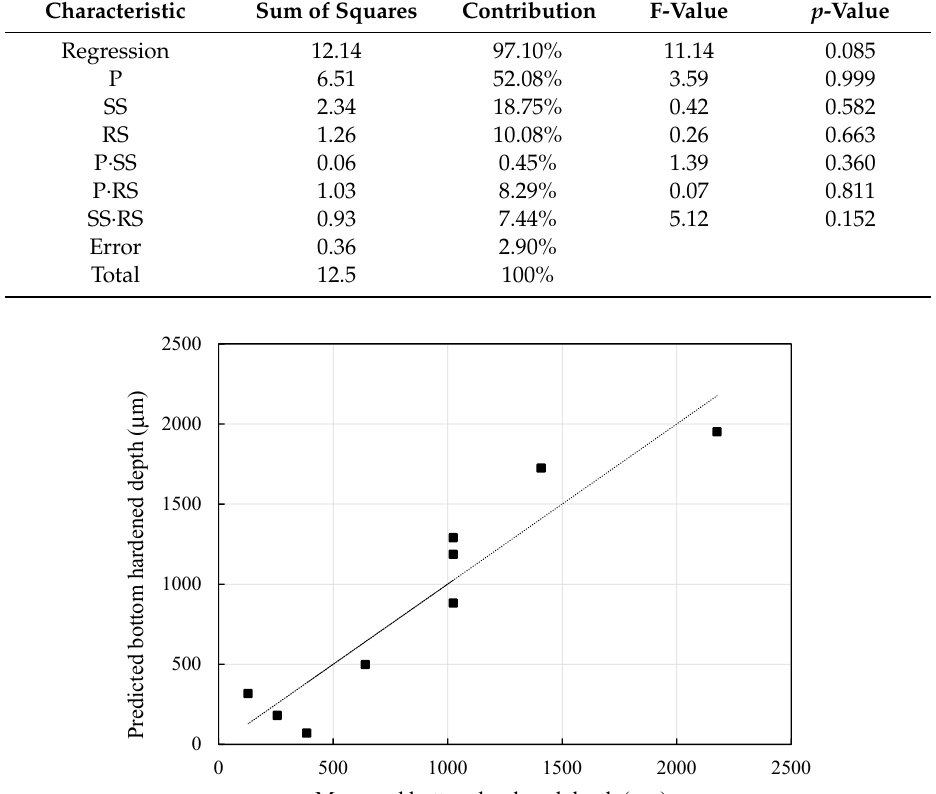
Figure 12. Main effects of the process parameters on the tooth bottom hardened depth. Figure 12. Main e ff ects of the process parameters on the tooth bottom hardened depth. Table 8. ANOVA analysis for the tooth bottom hardened depth. Table 8. ANOVA analysis for the tooth bottom hardened depth.